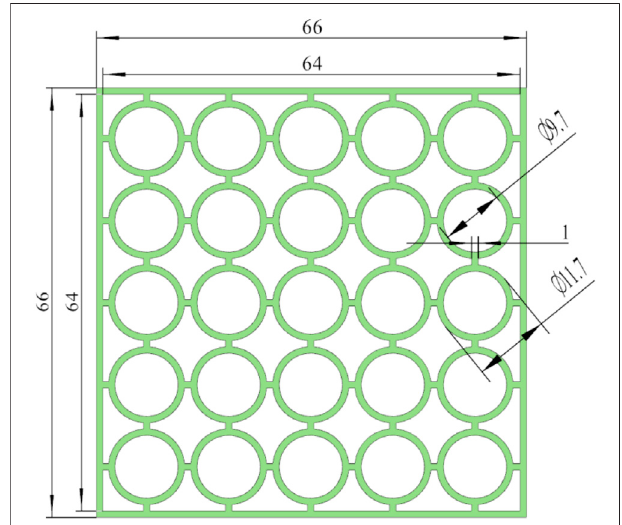
FIGURE 4 | Schematic diagram of the simpli fi ed spacer grid (SSG).